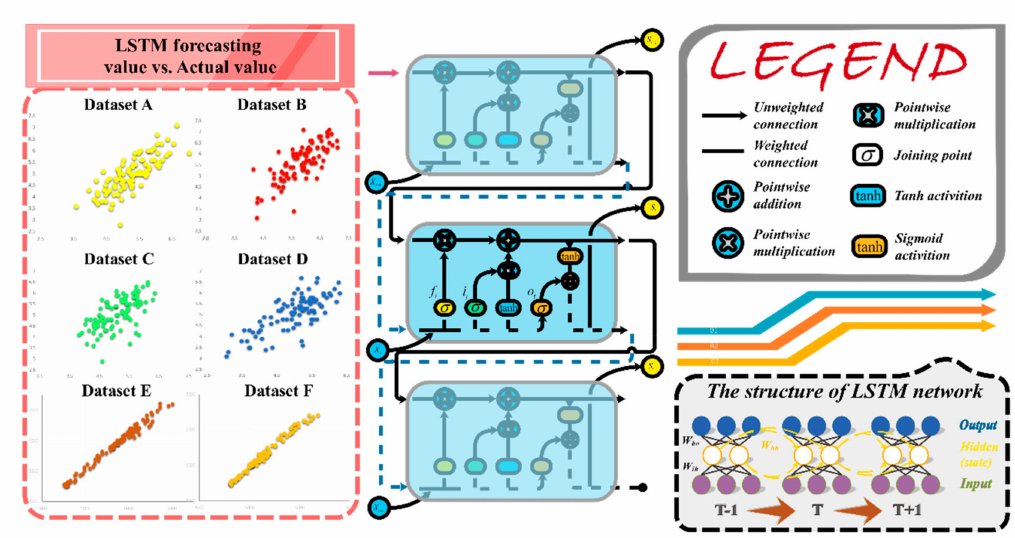
Figure 5. LSTM (long-short-term memory)